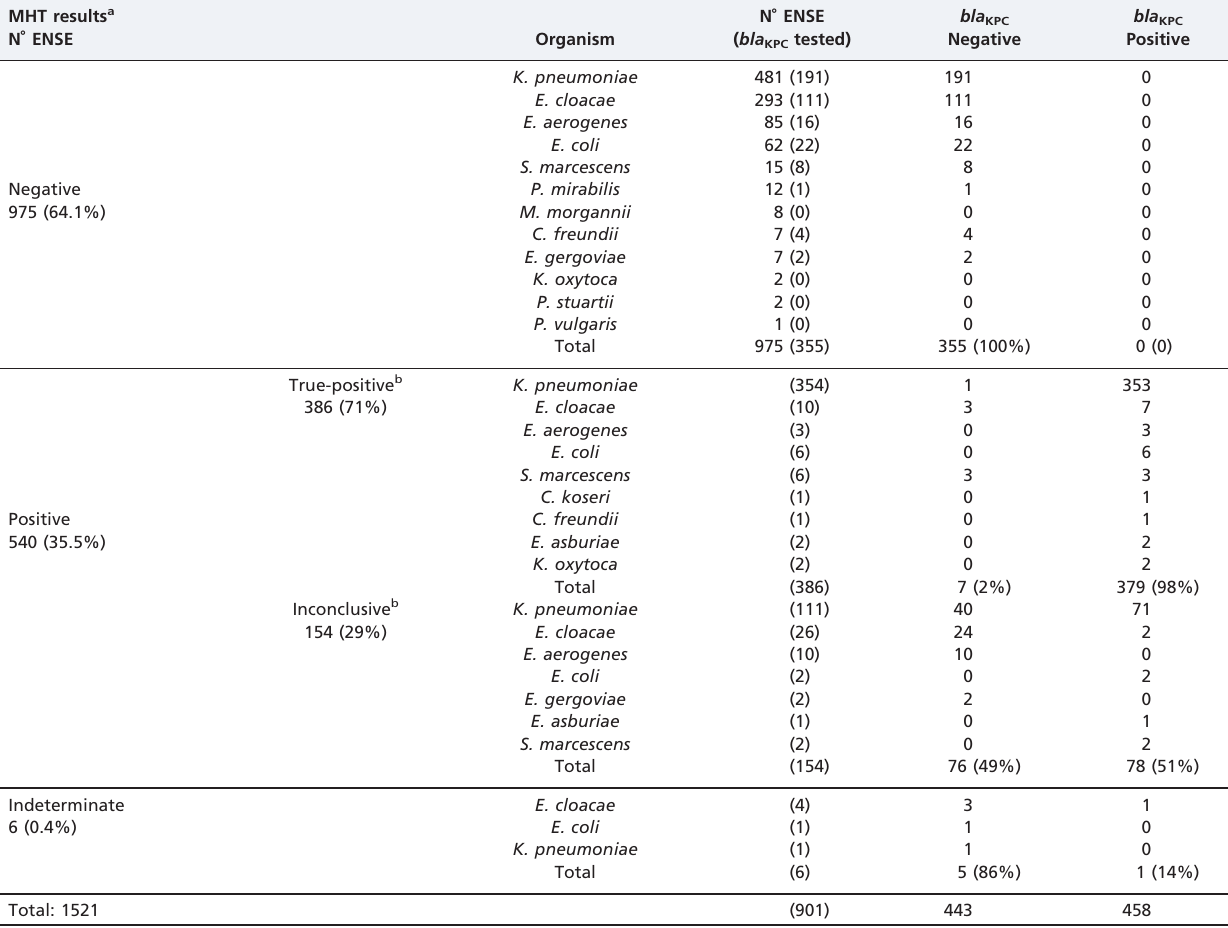
Table 1 - Distribution of 1521 Enterobacteriaceae isolates that were not susceptible to ertapenem (ENSE) according to the modified Hodge test (MHT) results and the presence of bla KPC .